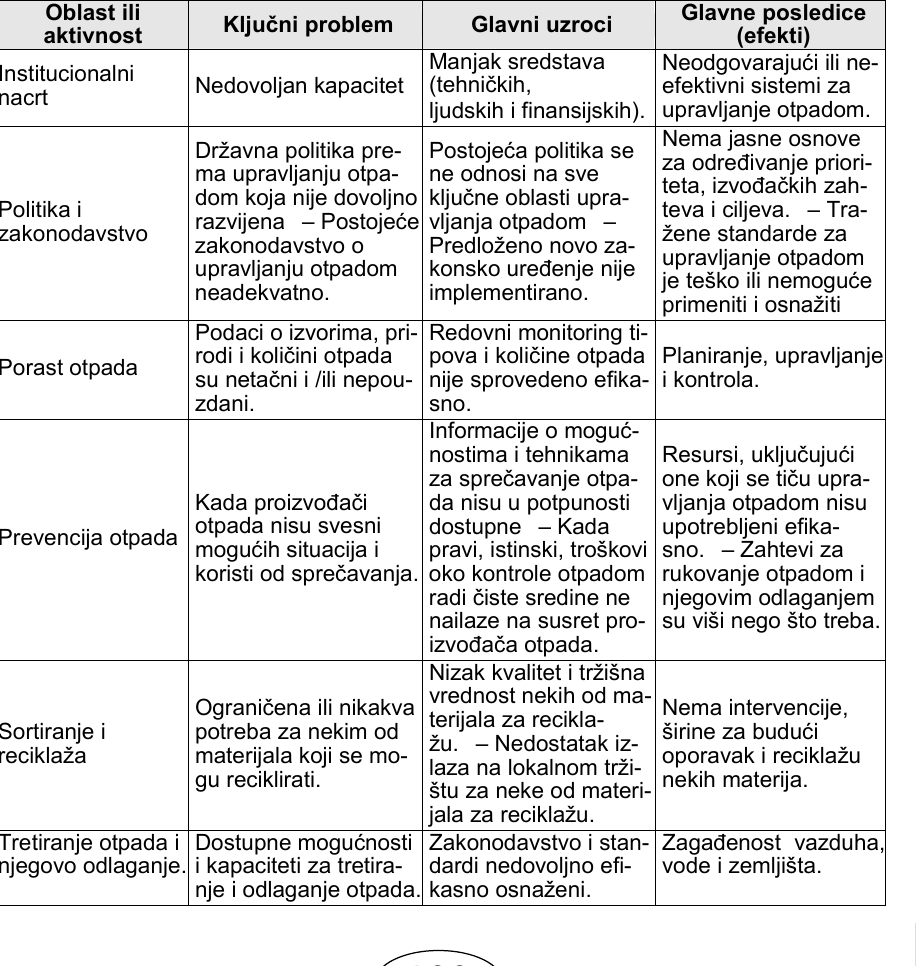
Definisanje i analiza problema u menadžmentu otpadom Definition and the analysis of the problems in waste